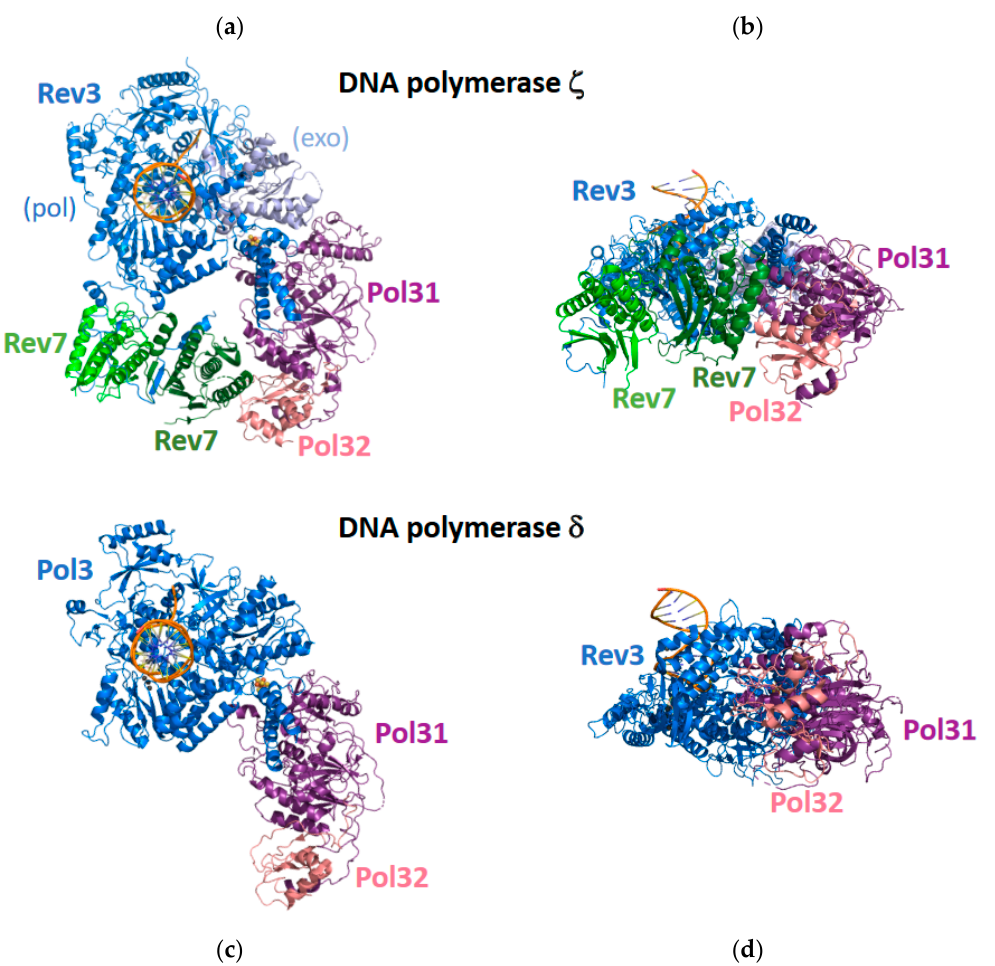
Figure 4. Cryo-EM structure of the full pol ζ complex. Shown are a top view ( a ) and a side view ( b ) of pol ζ . The polymerase domain of the Rev3 subunit is shown in blue, and the exonuclease domain of the Rev3 subunit is shown in light blue. The two Rev7 subunits are shown in green and light green. The Pol31 subunit is shown in purple, and the Pol32 subunit is shown in pink. Shown are a top view ( c ) and a side view ( d ) of pol δ . The catalytic Pol3 subunit is shown in blue, the Pol31 subunit is shown in purple, and the Pol32 subunit is shown in pink. This figure was generated with 7S0T.pdb [60] and 6P1H.pdb